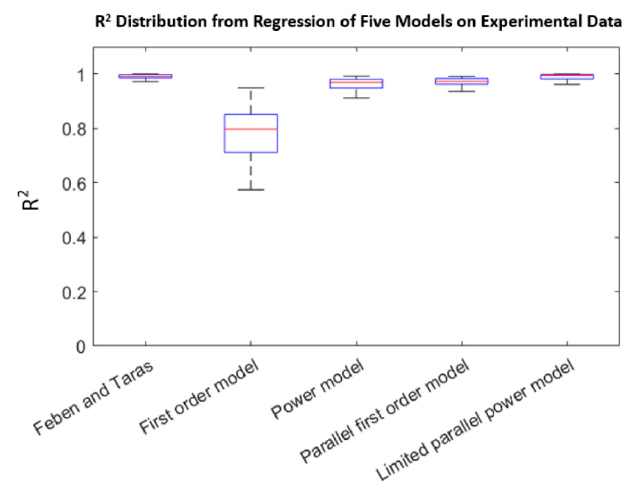
Figure 3. R 2 from model fitting on all 64 chlorine decay tests using the five models. From top to bottom of each box are the maximum value, third quartile, median, first quartile, and minimum value of R 2 for the specific model it represents.